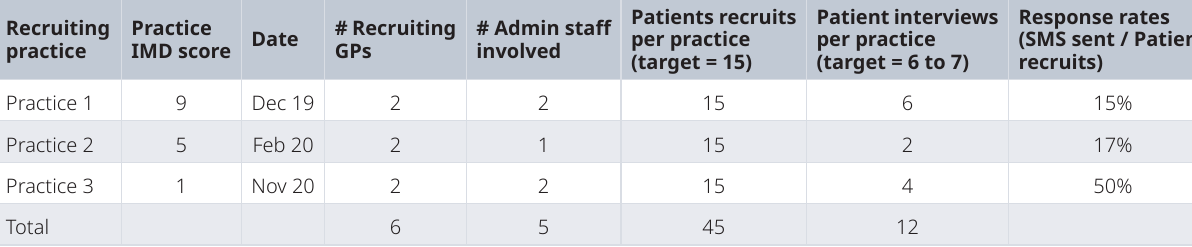
Table 3. Development of the pre-consultation form: GP and patient